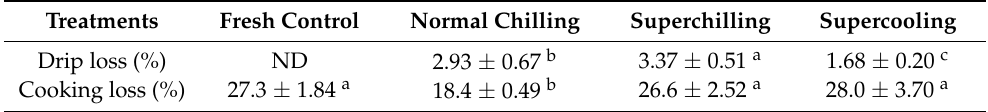
Table 2. Comparisons of drip loss and cooking loss of beef loins after 15 days of preservation. Treatments Fresh Control Normal Chilling Superchilling Supercooling Drip loss (%) ND 2.93 ± 0.67 b 3.37 ± 0.51 a 1.68 ± 0.20 c Cooking loss (%) 27.3 ± 1.84 a 18.4 ± 0.49 b 26.6 ± 2.52 a 28.0 ± 3.70